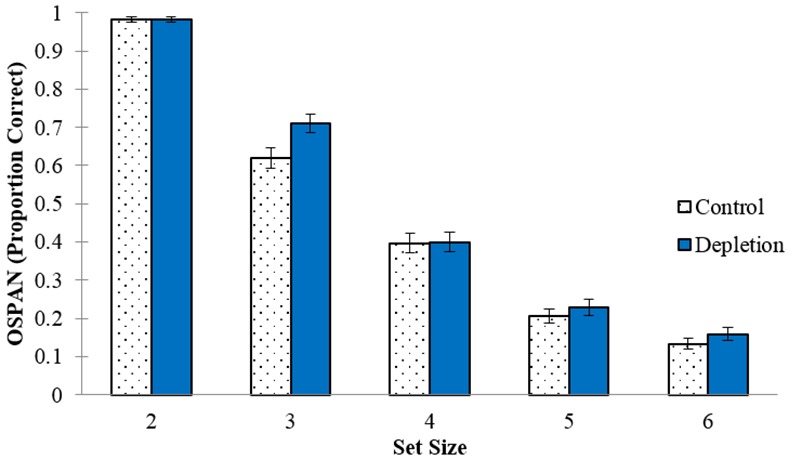
OSPAN performance between conditions at different set sizes.Error bars represent SEM.